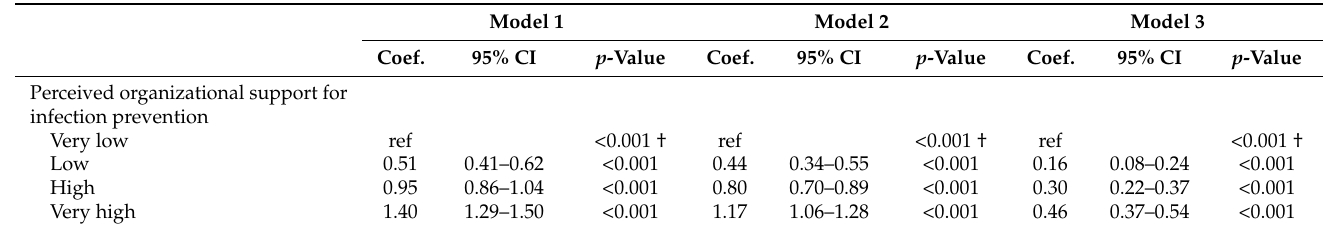
Table 2. Association between POS-IP at baseline and work engagement at